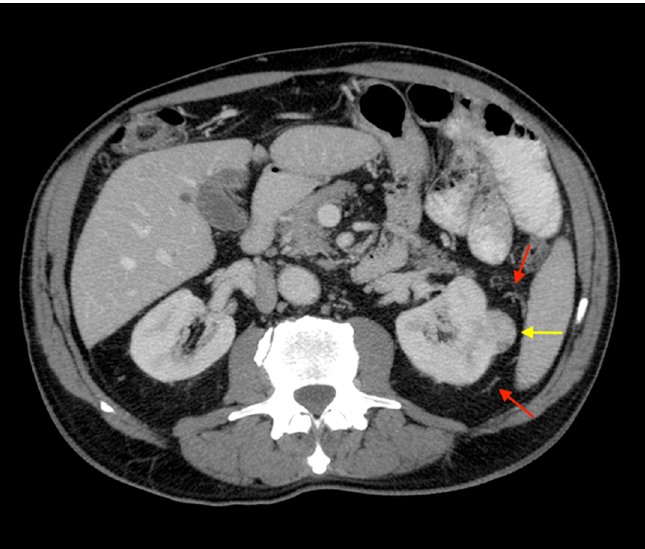
Figure 1. Axial CT image with maximum intensity projection (MIP) reconstruction showing ccRCC with T1a of locoregional staging ( yellow arrow ) and peritumoral collateral vessels ( red arrows ). Note that peritumoral collateral vessels can be present also in patients with early disease stages.